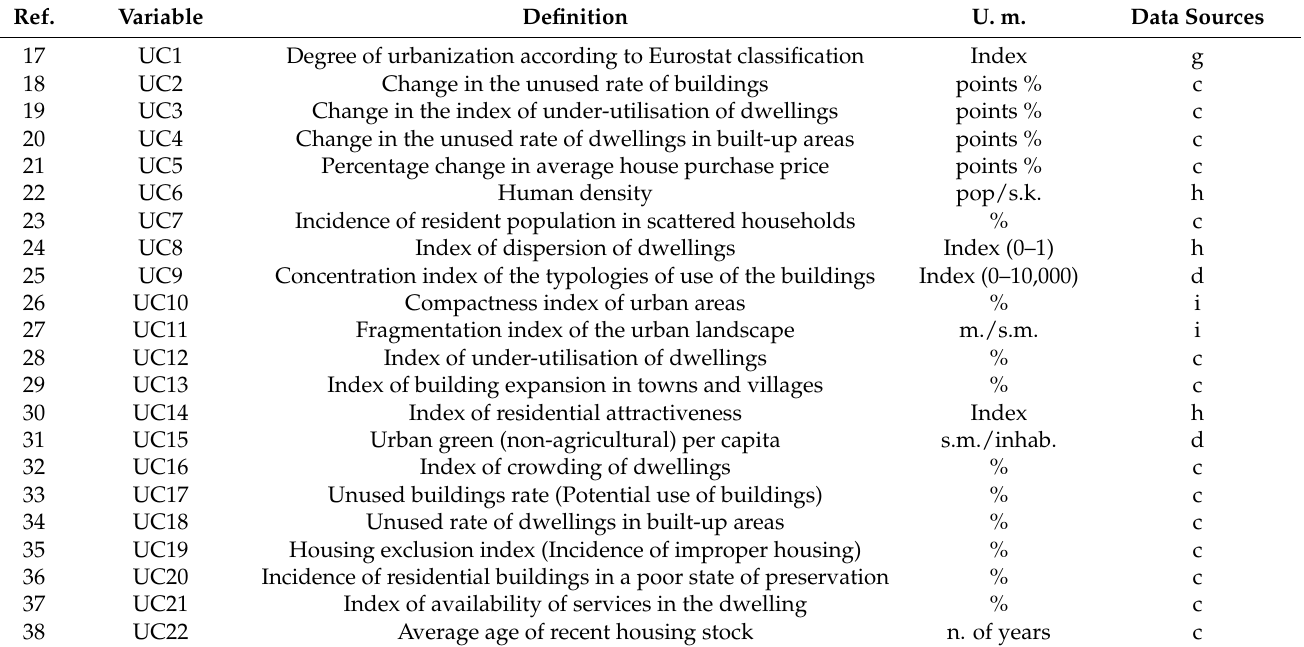
Table 2. Urban capital indicators.